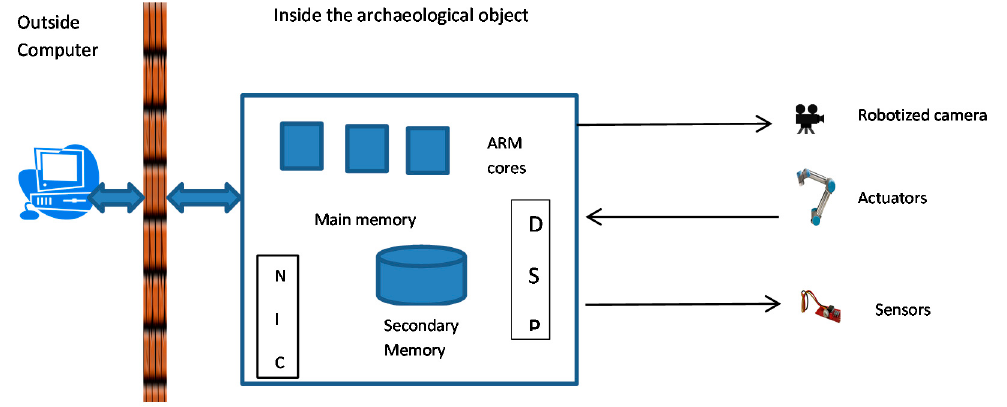
Figure 1. Configuration of the prototype system.